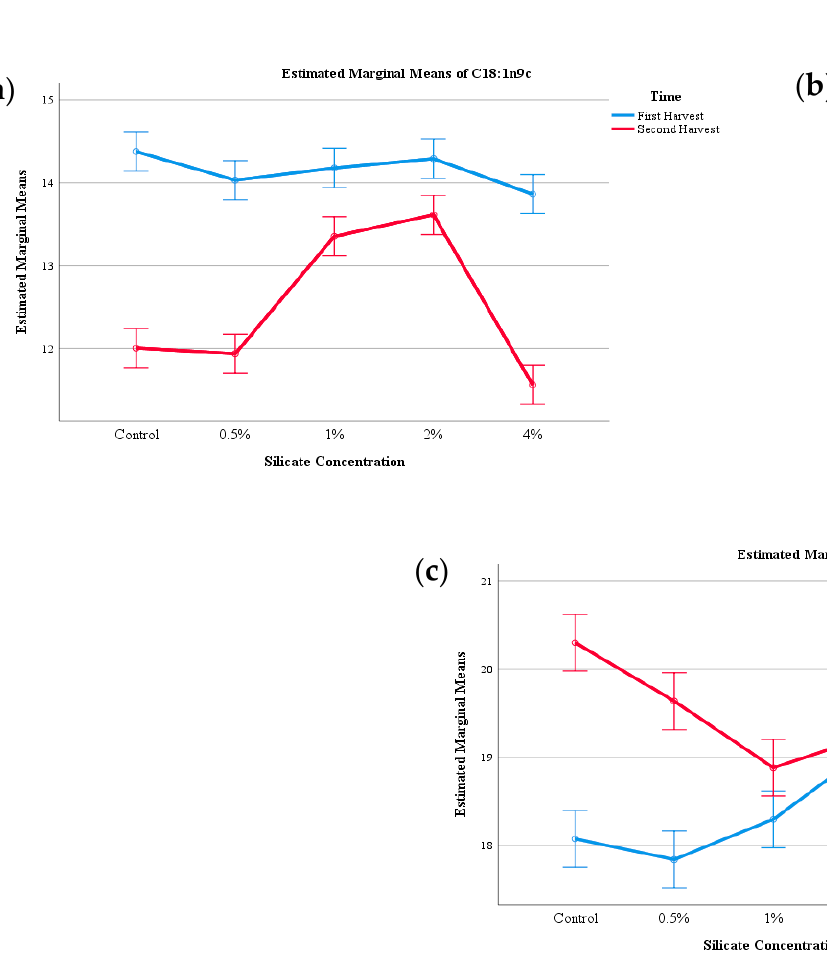
Figure 2. EMM plots of the Presidente Prudente mushrooms at different Si concentrations: ( a ) C18:1n9c (Octadec-9-enoic acid), ( b ) Saturated Fatty Acids (SFAs). EMM plots for Mogi-das-Cruzes: ( c ) SFAs.